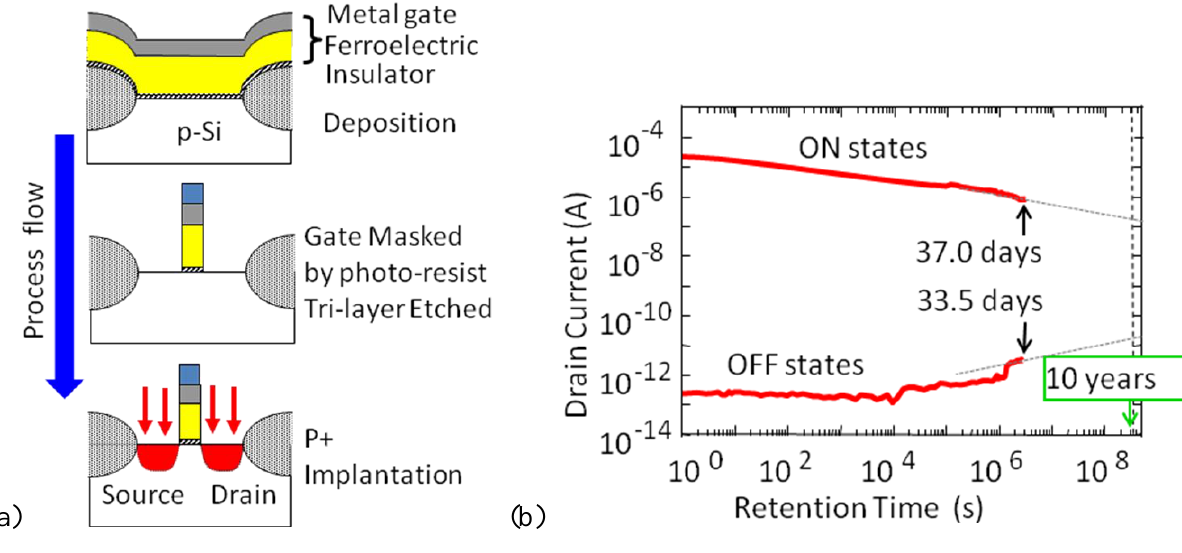
Figure 7. Electrical properties of FeFETs measured at elevated temperatures. (a) Drain current-gate voltage curves, and (b) the drain current retentions of a p -channel Pt/SBT/Hf-Al-O/Si FeFET. Thicknesses of the SBT and Hf-Al-O were 600 nm and 7 nm. Reprinted from [30] with permission of the American Institute of Physics. Good stability of FeFET data retention even at 120 °C was also supported by measuring the retentions of an n -channel Pt/SBT/HfO /SiON/Si FeFET (c). Thicknesses of the SBT and HfO 2 450 nm and 6 nm. Reprinted from [31] with permission of IOP Publishing